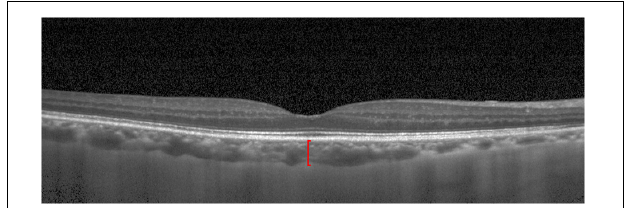
FIGURE 1 | Optical coherence tomographic image (enhanced depth imaging mode) showing the retina and the choroid. Red line: subfoveal choroidal thickness.